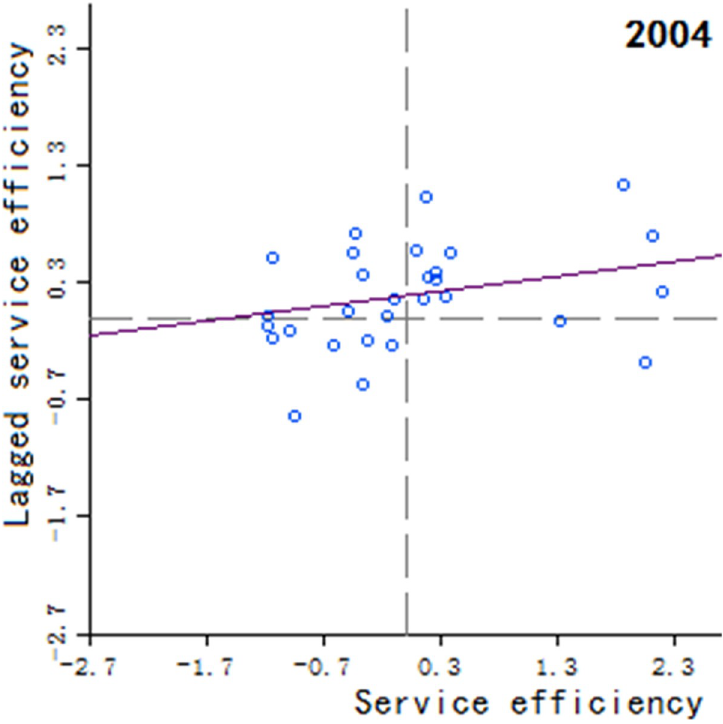
Fig 2. Scatter plot of China’s regional medical and health service level distribution from 2004 to 2018.